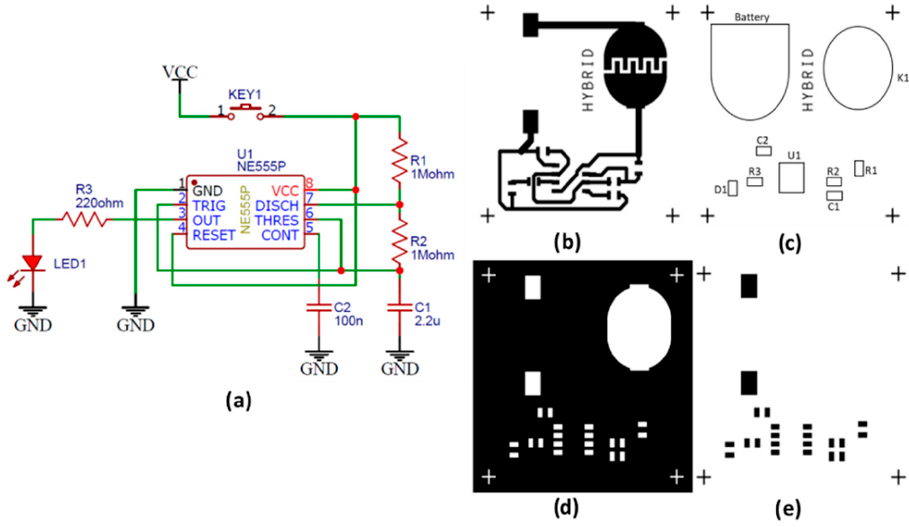
Figure A5. ( a ) Oscillator NE555 based, ( b ) layout, ( c ) top silk, ( d ) top resist and ( e ) top paste. Table A1. Commercial low ‐ temperature solder pastes.